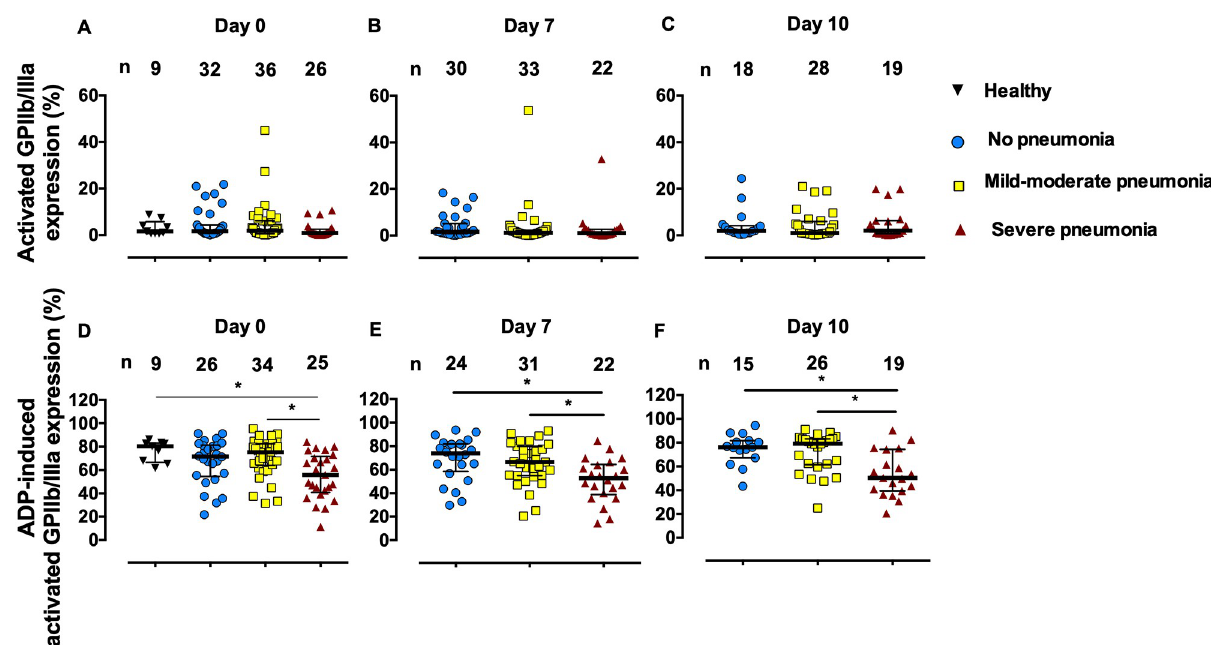
Fig 2. Activated glycoprotein (GP) IIb/IIIa expression on platelets without (A-C) and with 1 μ M ADP stimulation (D-F) in healthy control subjects and COVID-19 patients on admission days 0, 7, and 10. Lines represent medians and interquartile ranges. � p < 0.05 by Kruskal-Wallis